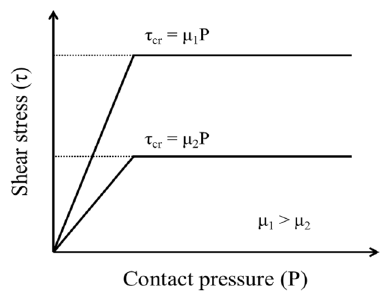
Figure 3. Coulomb friction model (modified after Kim [14]).